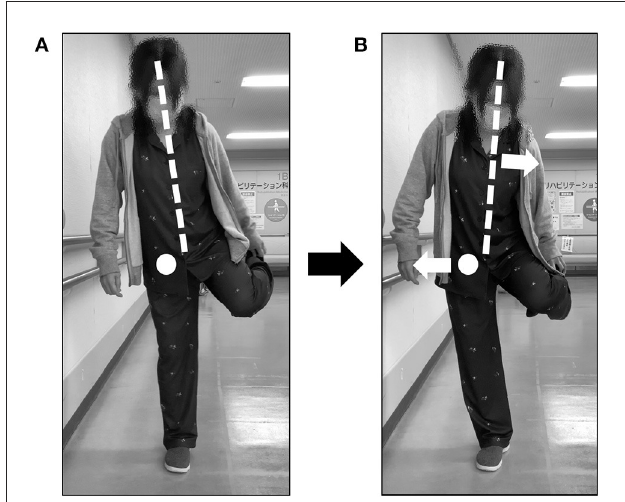
FIGURE3 Points for which motion instruction was provided. (A) A posture with a risk of falling was indicated. (B) The posture of the patient after movement instruction was given. Trunk alignment was indicated by a dotted line and the hip axis was indicated by a circle. Arrows indicated the movement direction from the posture before the change (A)